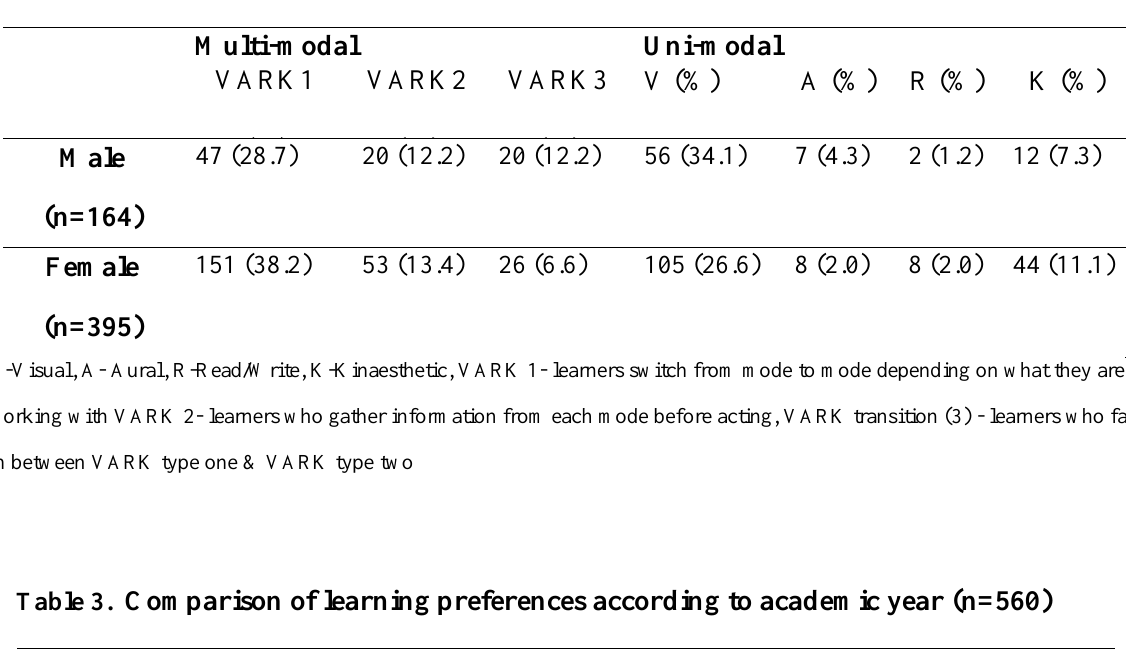
Table 2. Comparison of learning preferences according to gender (n=559)